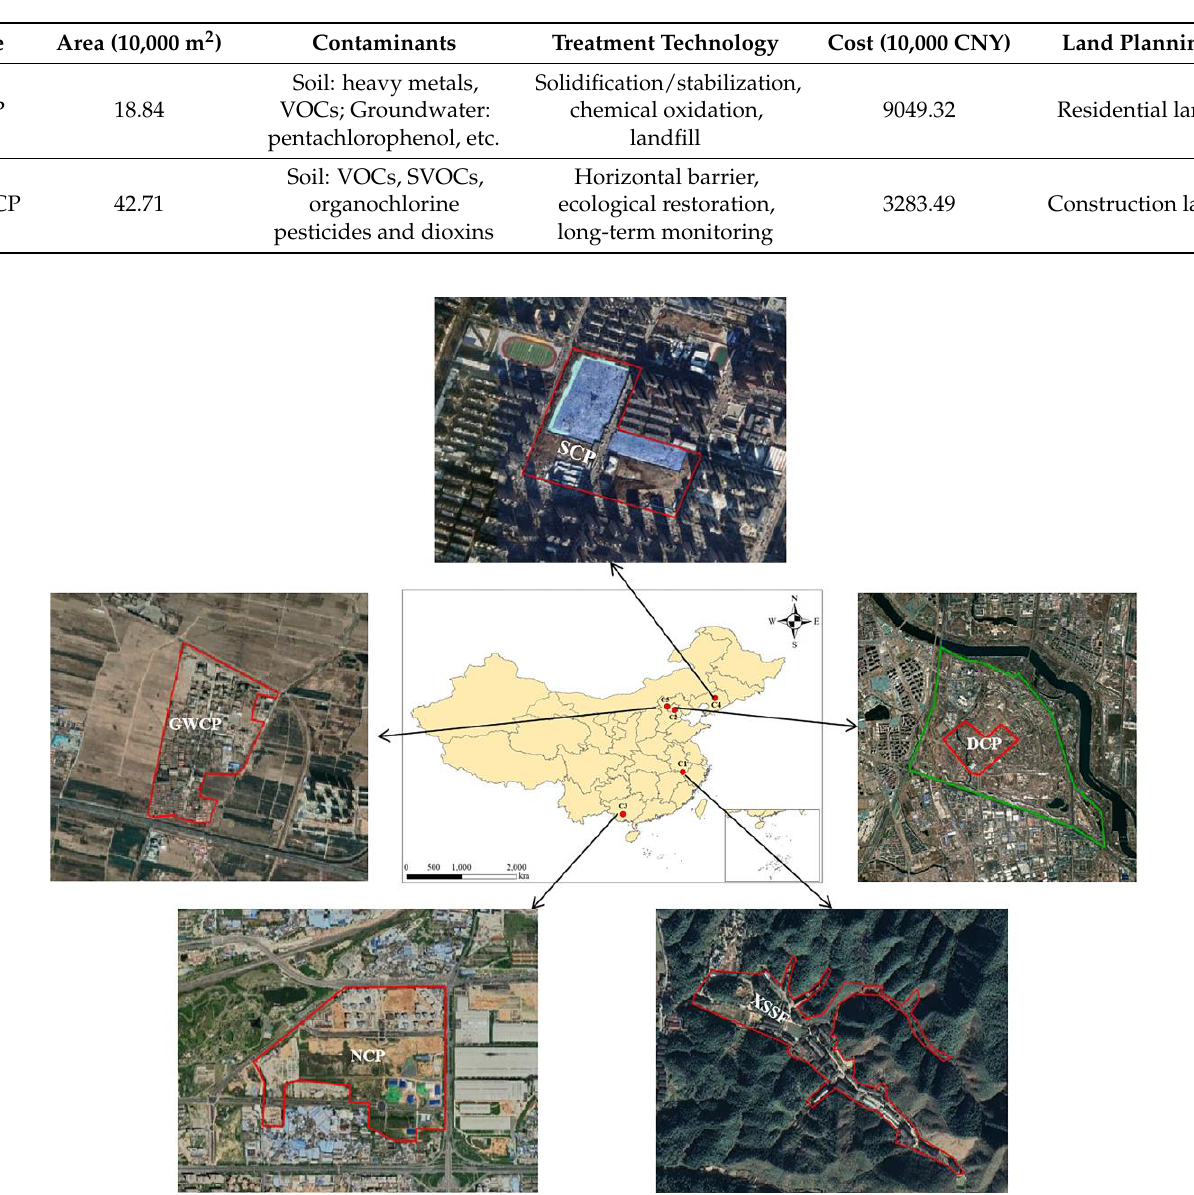
Figure 1. Geographic locations of the studied sites.